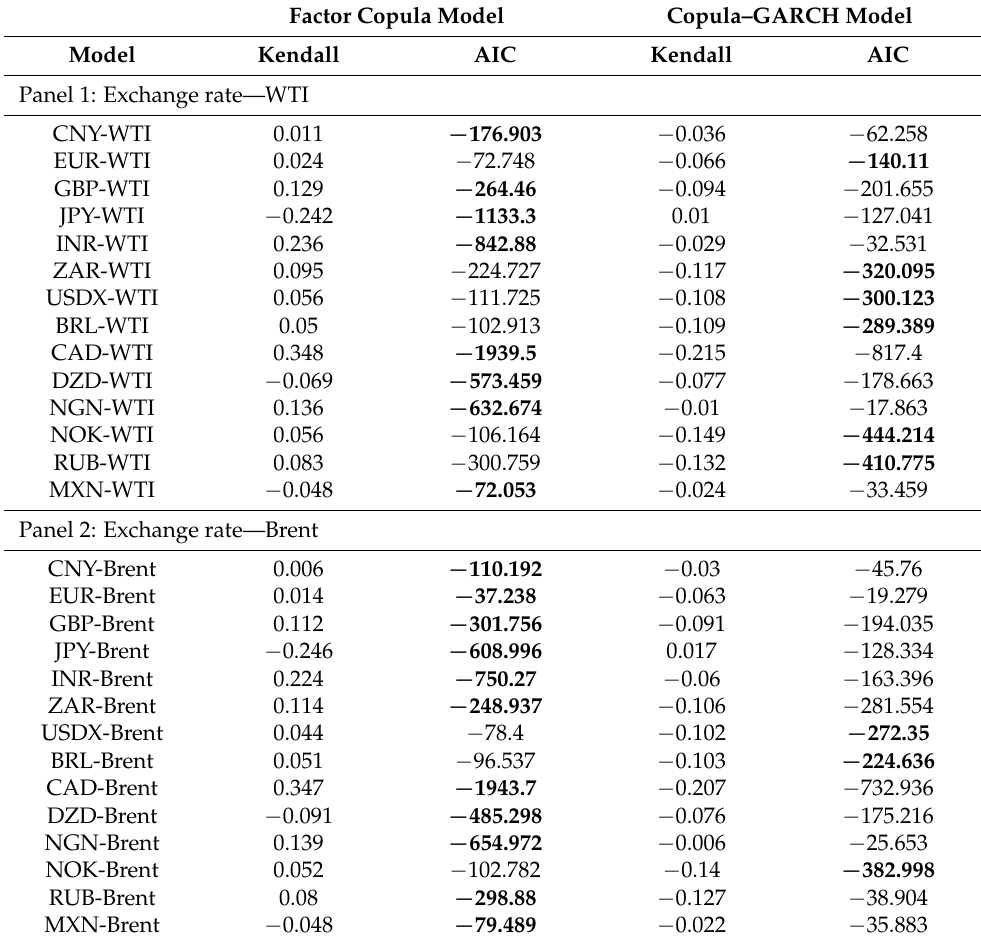
Table 3. The comparison of the optimal time-varying copulas between the factor copula and Copula– GARCH models.